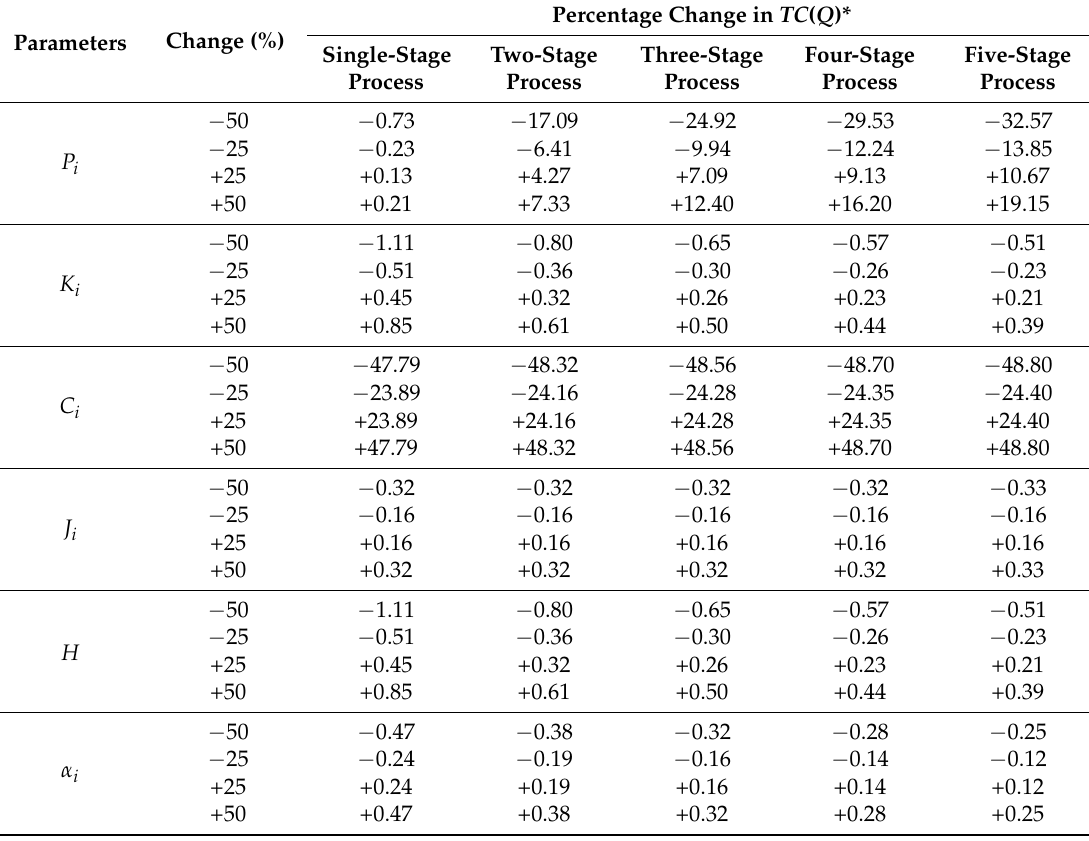
Table 2. Sensitivity analysis of key parameters for Example